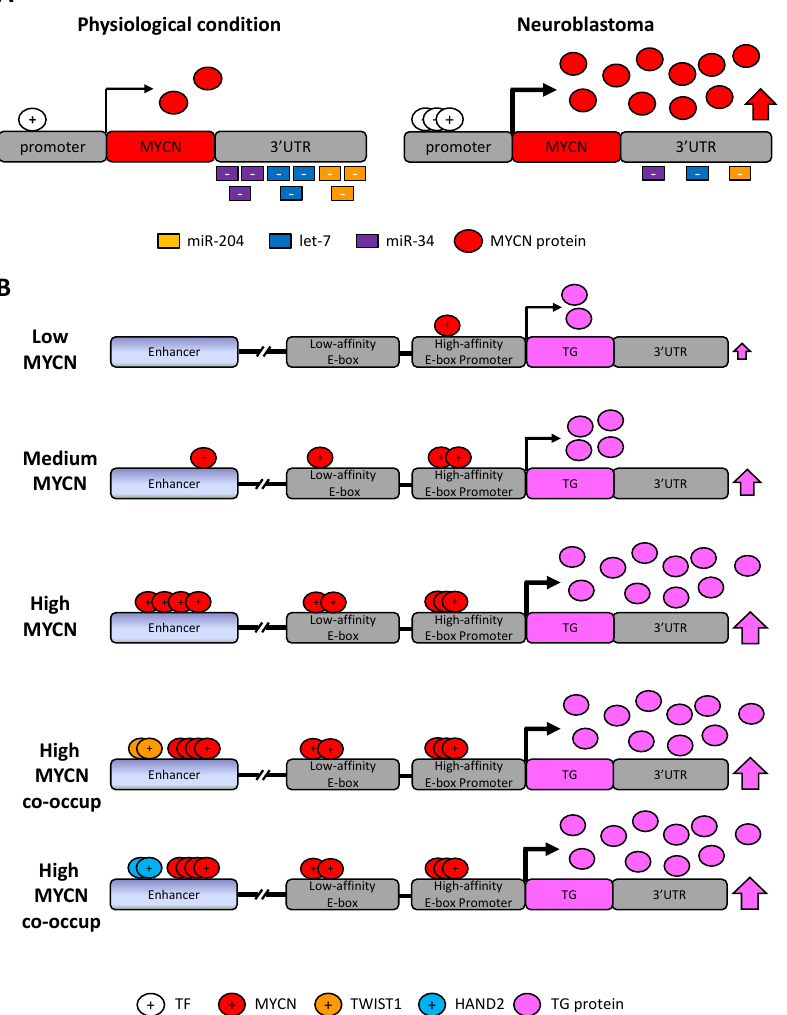
Figure 6. Schematic illustration of MYCN enhancer invasion/co-occupancy effects. ( A ) The two images show regulation of MYCN expression by a general activating TF (“+” white circle) in both physiological and NB conditions, where MYCN is amplified/overexpressed. The thick arrow indicates an increased level of MYCN expression in NB with respect to physiological conditions. The number of circles represents the amount of protein products, reflecting the levels of gene expression. While under physiological conditions there are adequate levels of TS microRNAs (rectangles), low TS miRNA levels are present in NB. ( B ) From the 5 ′ to the 3 ′ end, a general MYCN target gene (TG) is represented by its enhancer (faded blue), high and low affinity promoters with E ‐ box (grey), coding region (pink) and 3 ′ UTR (grey). Circles represent a general TF (white), TWIST1 (yellow), HAND2 (cyan) and MYCN (red). The different levels of TG products are shown as consequences of low, medium and high MYCN levels, the latter in absence and the presence of additional TFs co-occupying the TG enhancer. “+” within circles indicate activating effects of TFs. The number of pink circles represents the amount of TG products reflecting levels of gene expression. Pink arrows on the right indicate the resulting level of TG expression for each